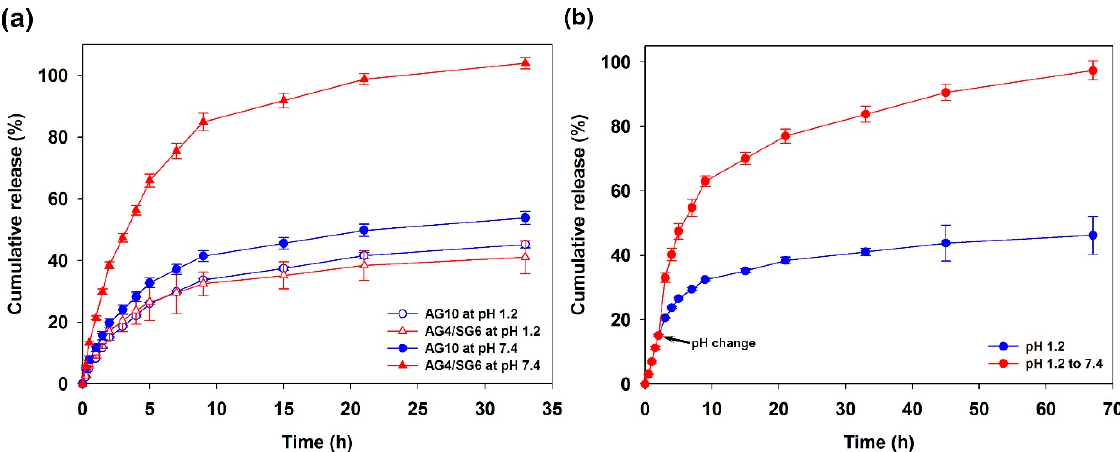
Figure 8. CPFX cumulative release graphs of AG10 and AG4/SG6 hydrogels loaded with CPFX in ( a ) pH media (pH 1.2 and 7.4) at 37 °C and ( b ) under pH change from 1.2 to 7.4 at 2 h.